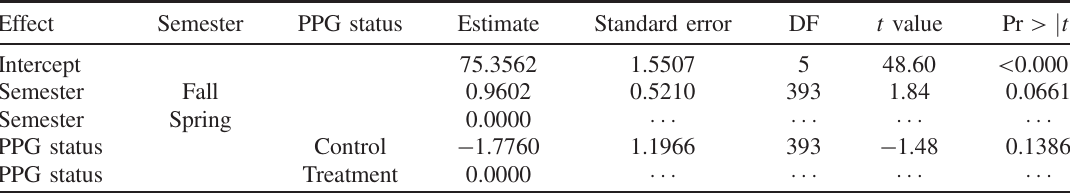
TABLE V. Model results for semester chemistry performance.